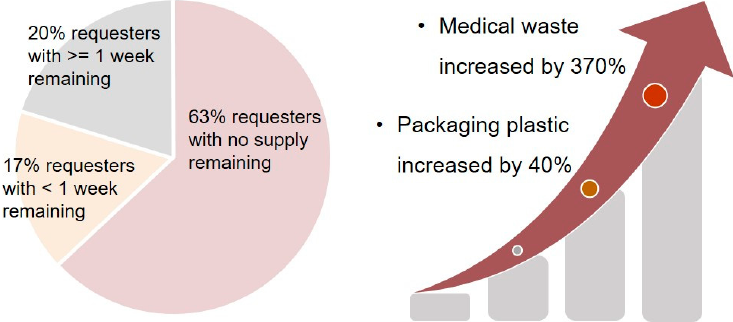
Figure 6. Respirator shortage and medical waste increase as a consequence of COVID-19.